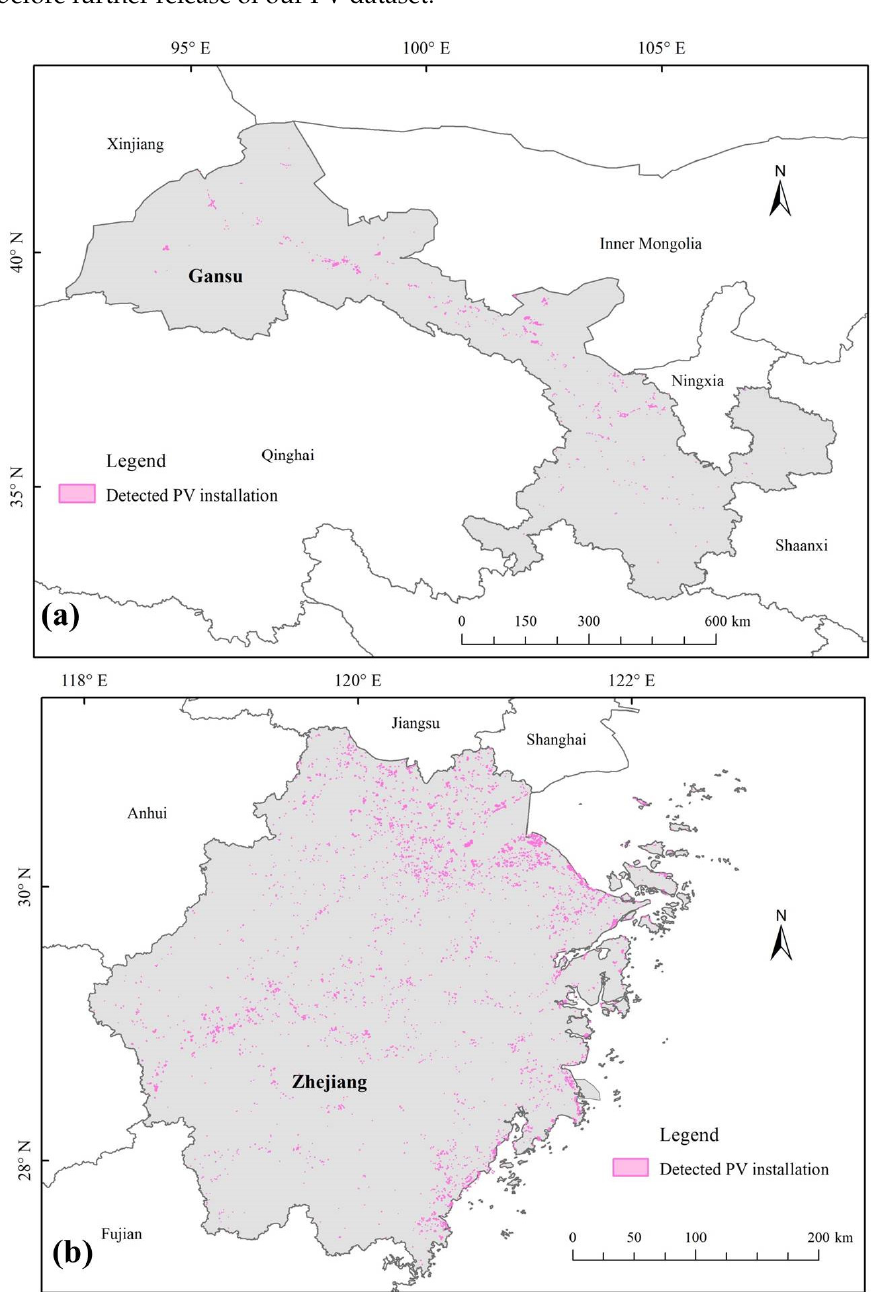
Figure 11. The final spatial distribution of PV extraction in ( a ) Gansu and ( b ) Zhejiang Province.